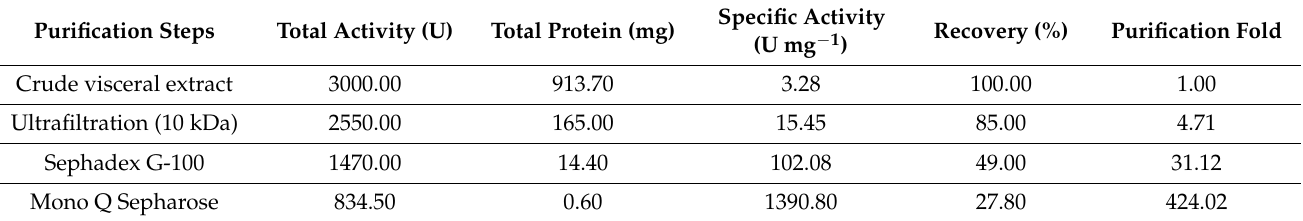
Table 1. Summary of purification of the digestive α -amylase (BCA) from blue crab